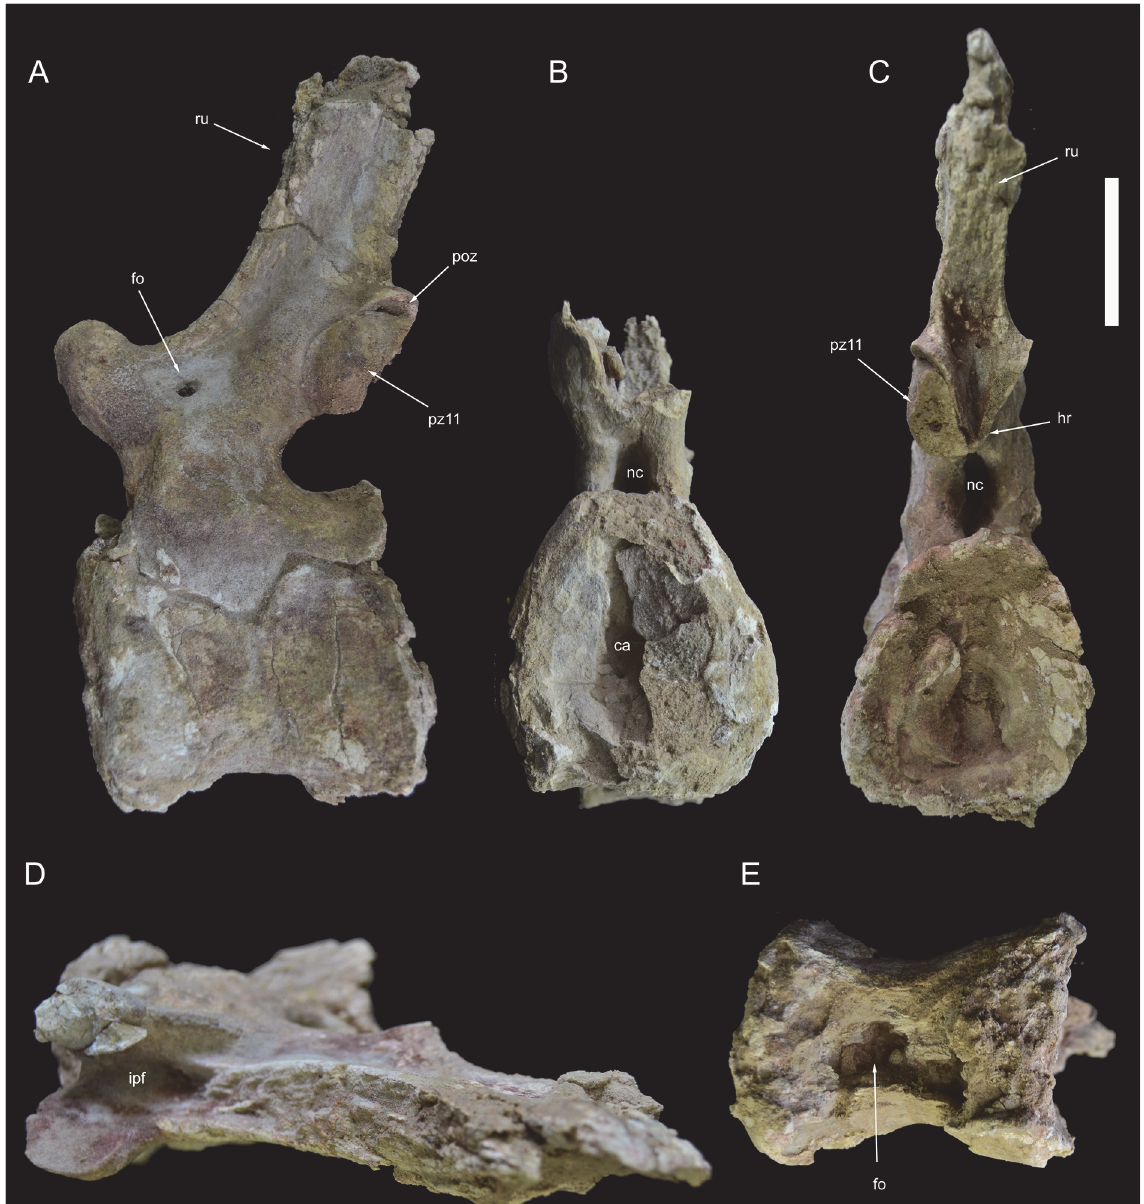
Fig 12. Caudal vertebra 10 of Tataouinea hannibalis . Vertebra in left lateral (A), proximal (B), distal (C), dorsal (D) and ventral (E) views. Scale bar: 10 cm. Abbreviations: fo, fossa; hr, hyposphenal ridge; ipf, interprezygapophyseal fossa; nc, neural canal; poz, postzygapophysis; pz11, fragment of caudal 11 left prezygapophysis; ru,